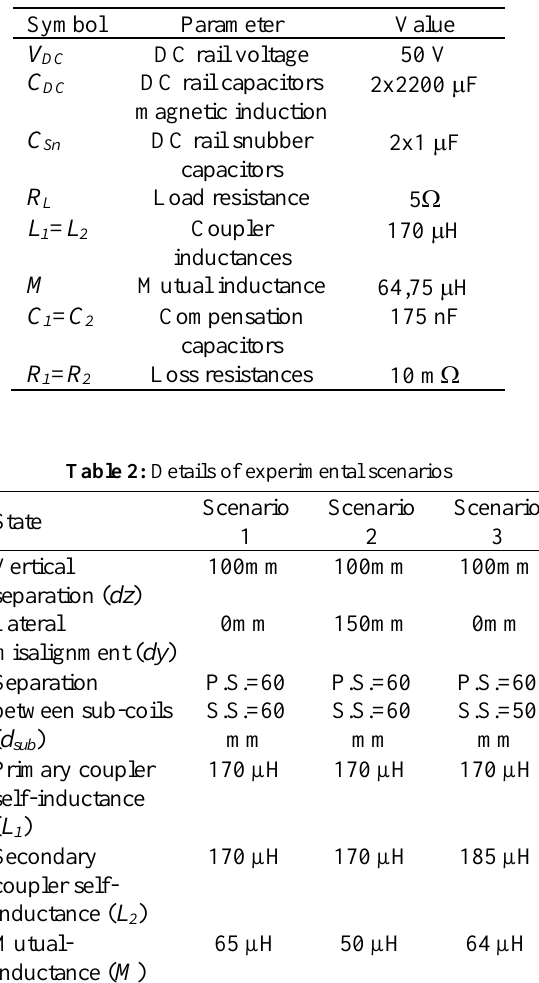
Table 1: Component values and other details of experimental setup